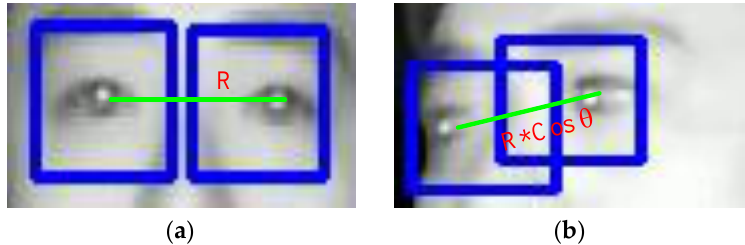
Figure 6. Distance between eyes: ( a ) eyes facing front ( b ) face rotated by angle θ.